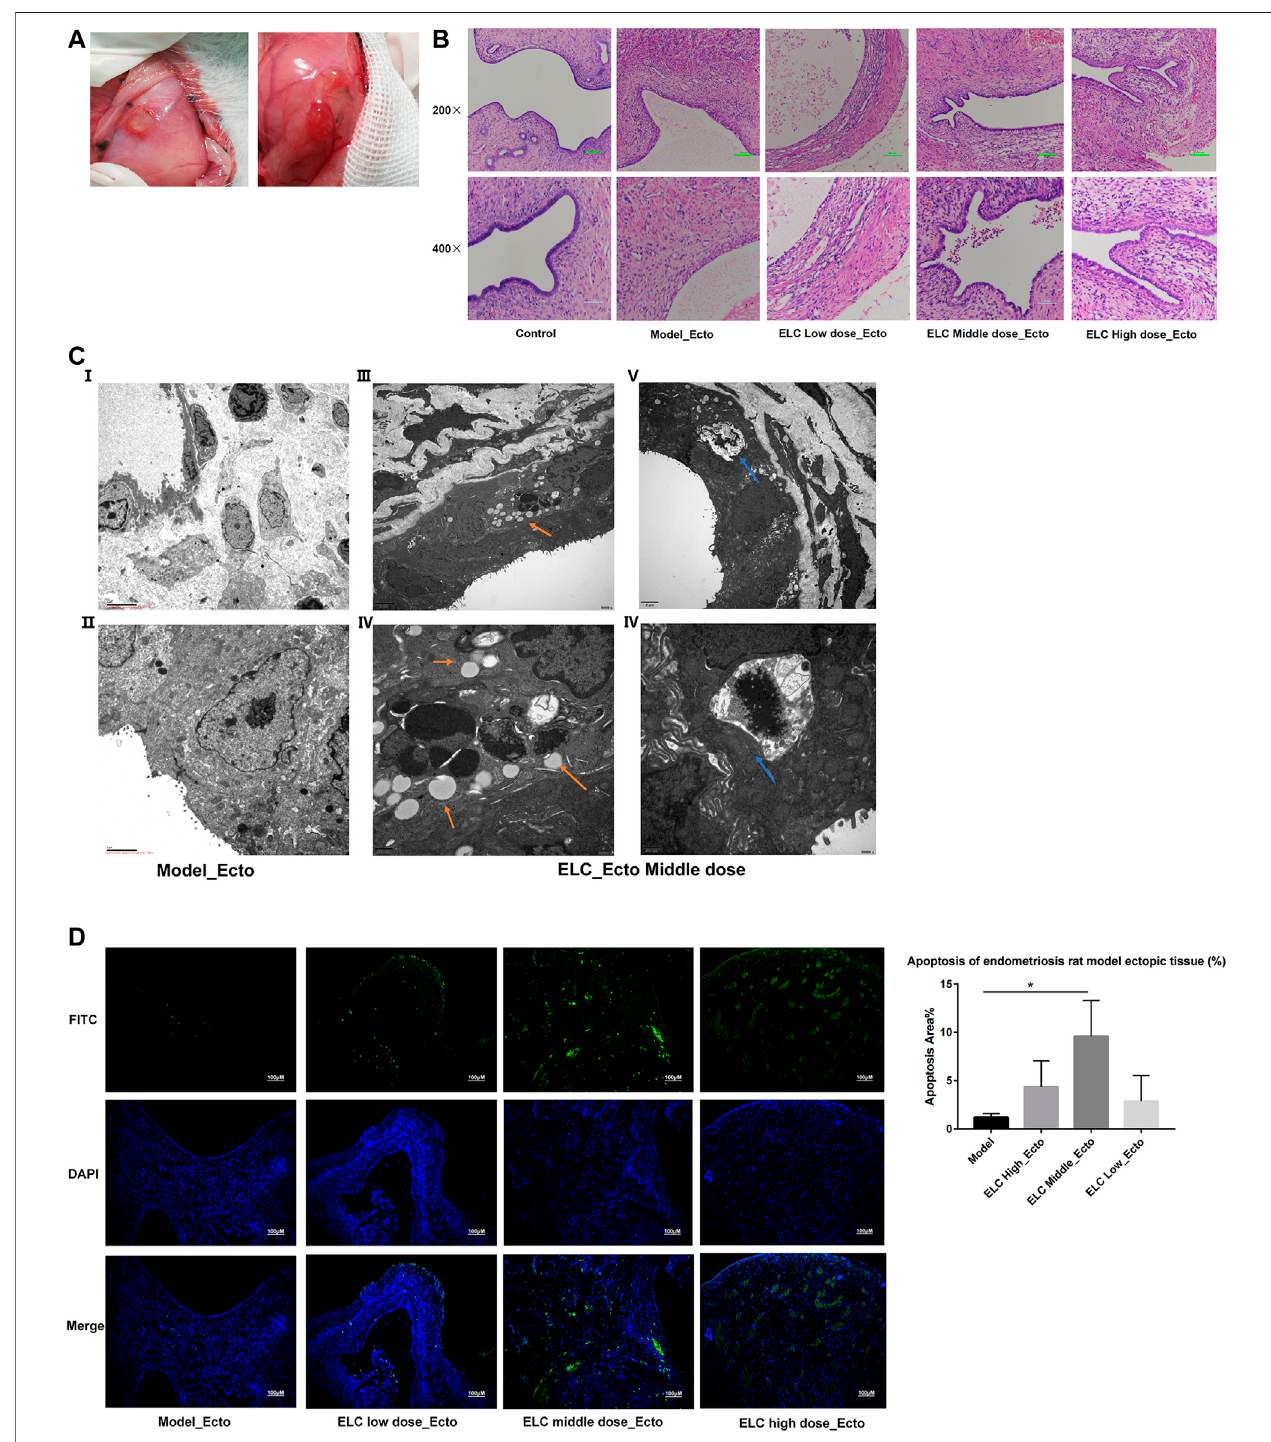
FIGURE 3 | Pathological microstructure and ultrastructure. (A) Graphs of ectopic endometrium lesions in endometriosis rat models. (B) Microstructure of the ectopic endometrium by HE staining (200 × and 400 × ). (C) Ultrastructure of ectopic endometriotic lesions. The blue arrow indicates autophagosome. The orange arrow shows the structure of apoptosis bodies. (D) Detection of apoptosis was using the TUNEL assay (100x). Apoptosis in ectopic endometria of different groups was observedbytheTUNELassay.DAPI-stainednucleiappearedinblue.Green-stainedtissueappearedingreenduetothepresenceofapoptoticcells.Theapoptotic index (%) of ectopic endometrial tissues was signi fi cantly higher in middle doze group ( n (cid:2) 4).